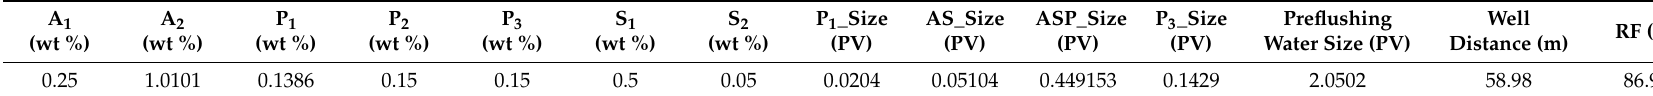
Table 6. Optimal design of the 13 parameters for providing the maximal NPV.